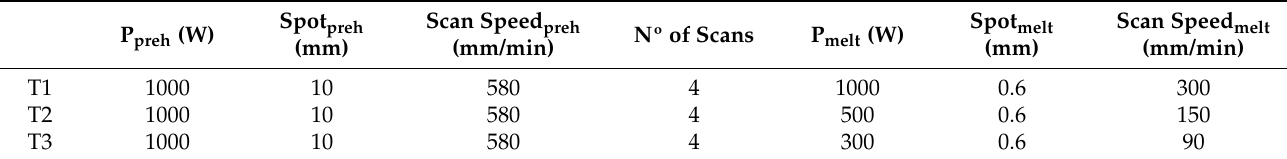
Table 6. Experimental conditions for preheating and melting.